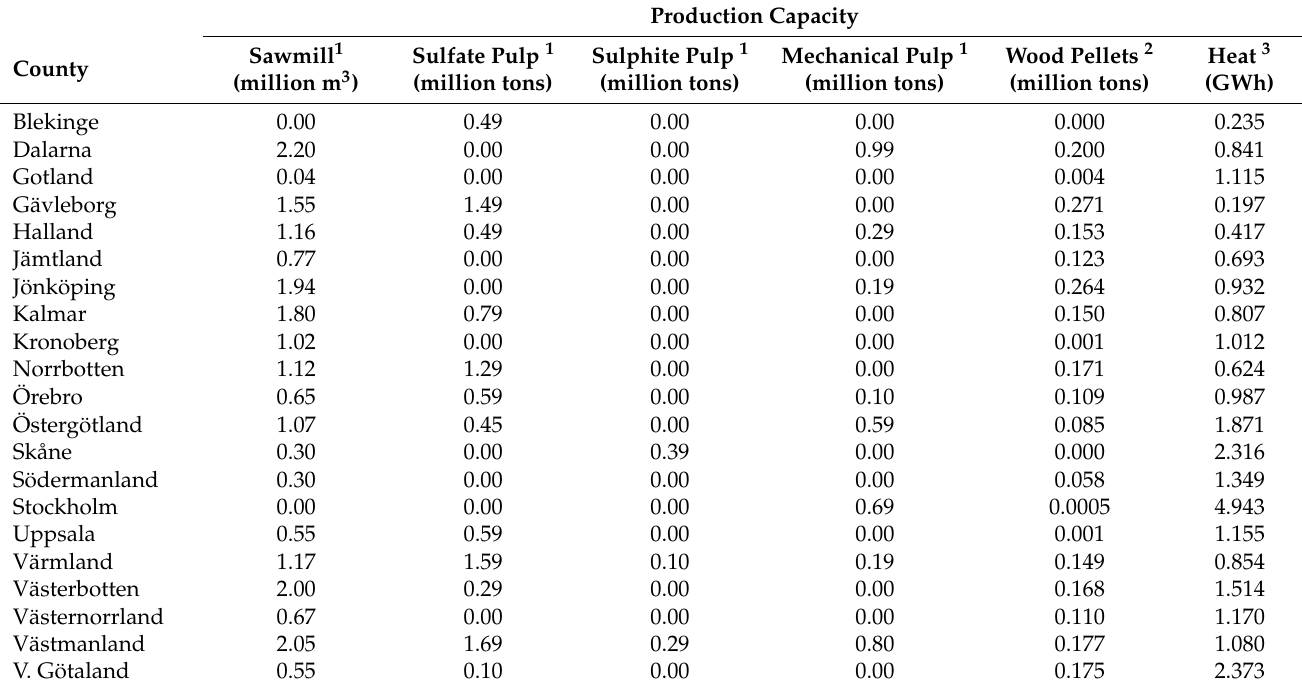
Table A4. Forest industry production